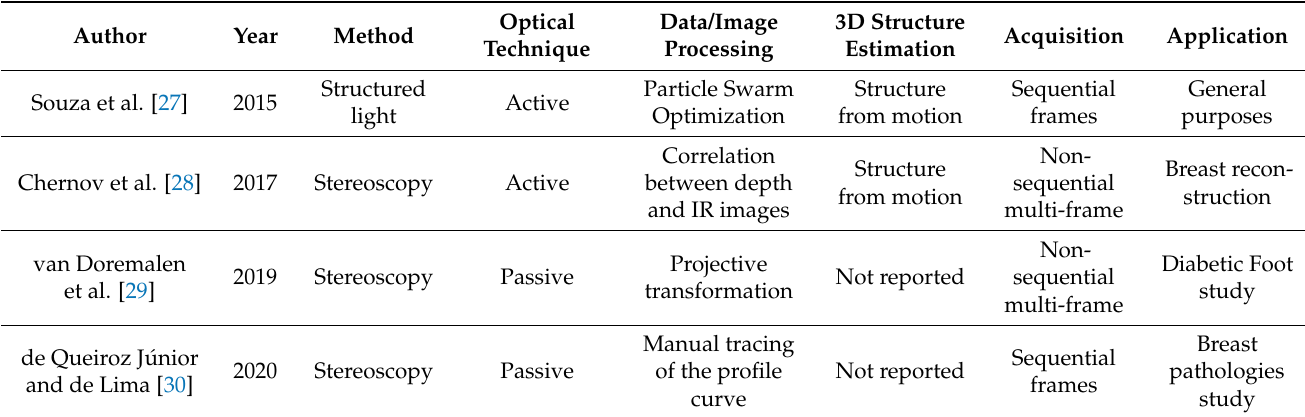
Table 3. Overview of the 3D reconstruction techniques based on visible-light images and/or IR images. Although the acquisition techniques are different, the objective is common for all the reported papers for a 3D structure